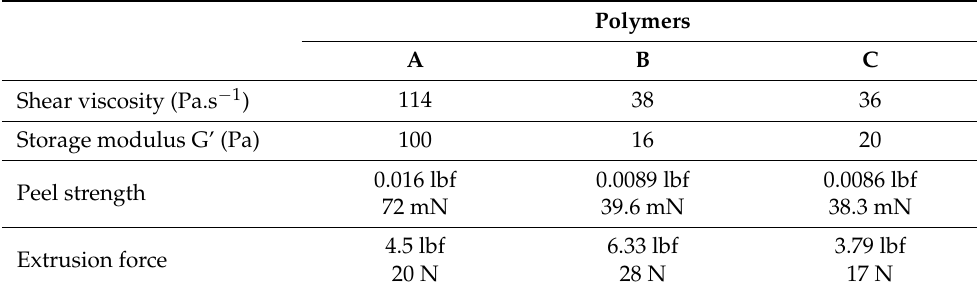
Table 2. Summary of the evaluated physical characteristics of the products.